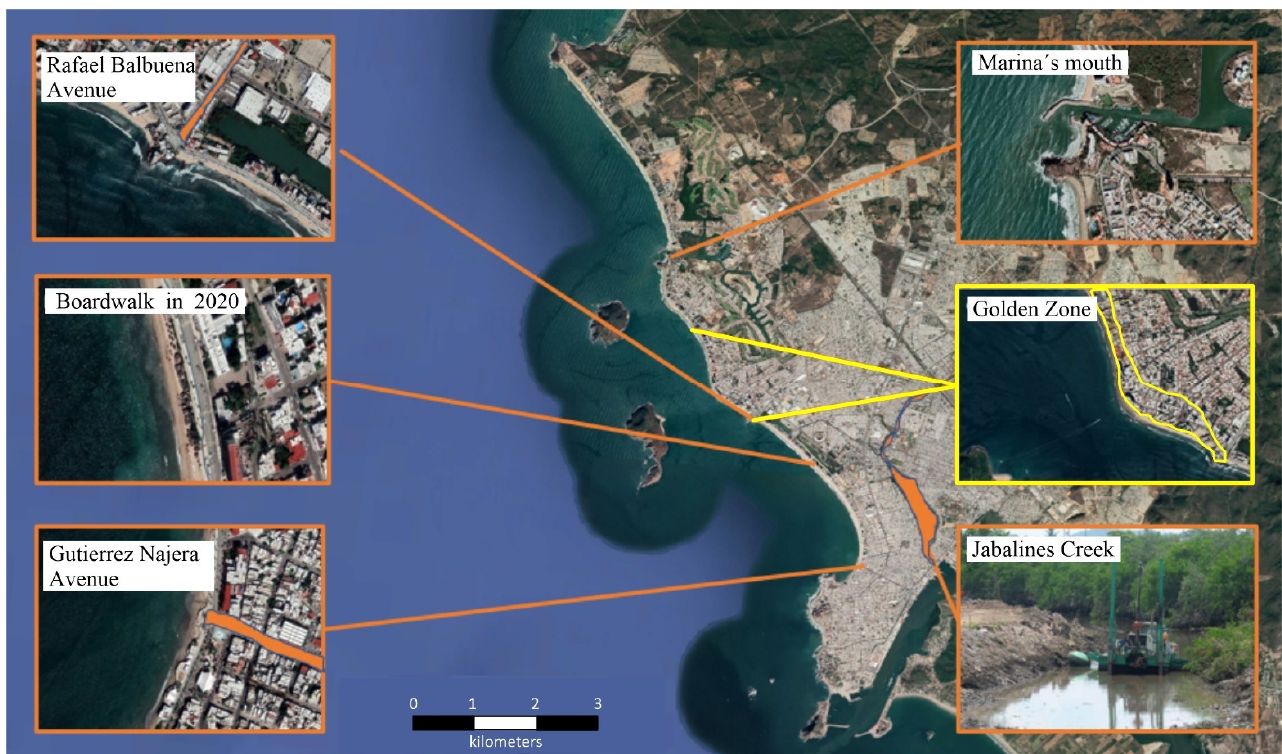
Figure 2. Locations with severe erosion problems on the coast of Mazatlan.